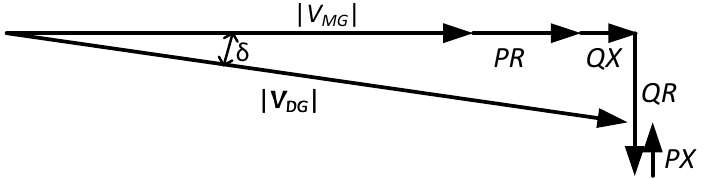
Figure 2. Phasor diagram of voltages in simple power system model.